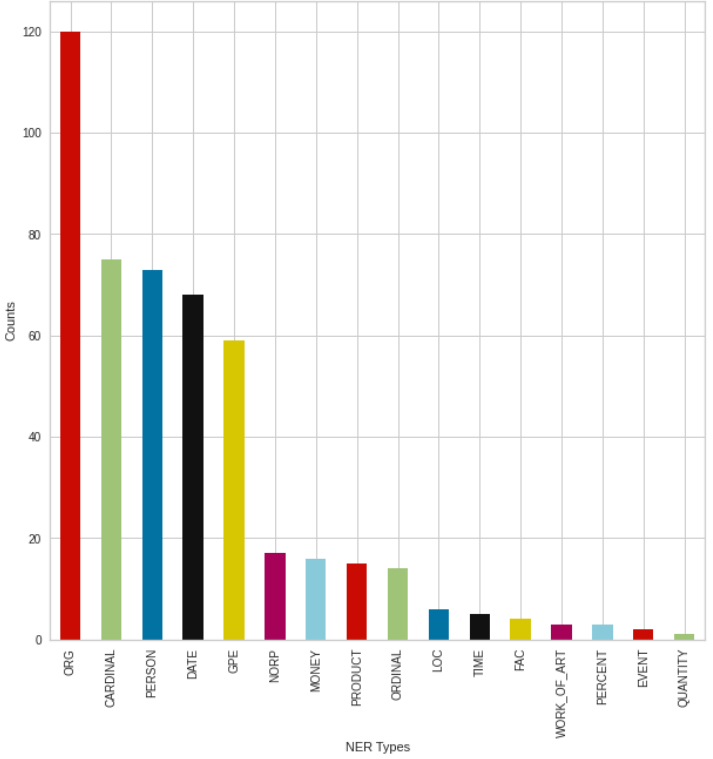
Figure 17. NER types of the positive tweets. The time period stands between 29 August 2021 and 31 August